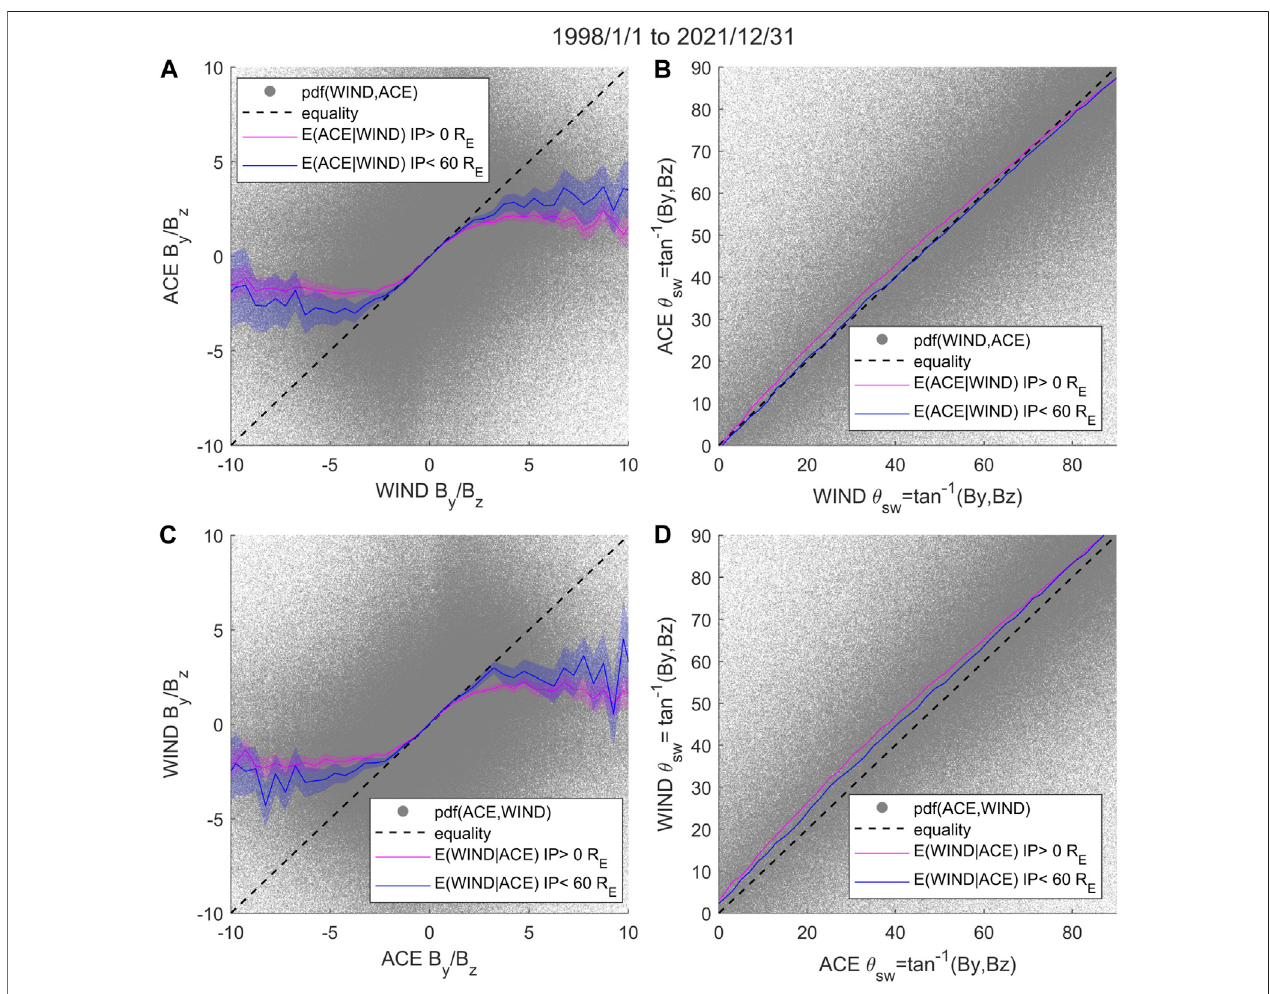
| WIND B y ) is shown with the magenta line. Blue line plots the same B z B z